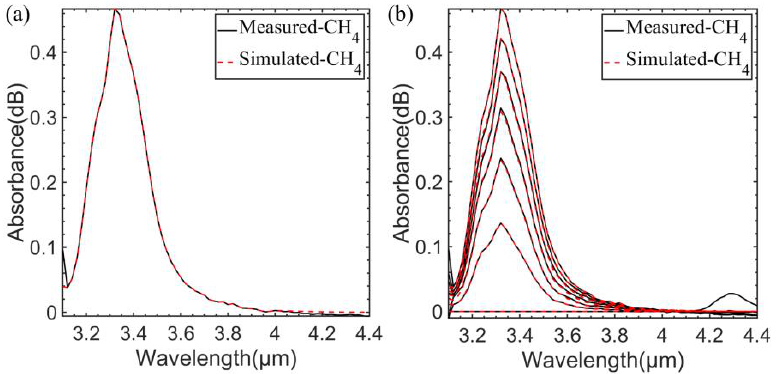
Figure 9. Predicted concentrations of CH 4 and C 2 H 6 using measured mixed gases.